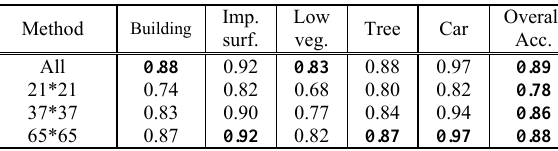
Table 3. Performance comparison (F1-score) between single- resolution and